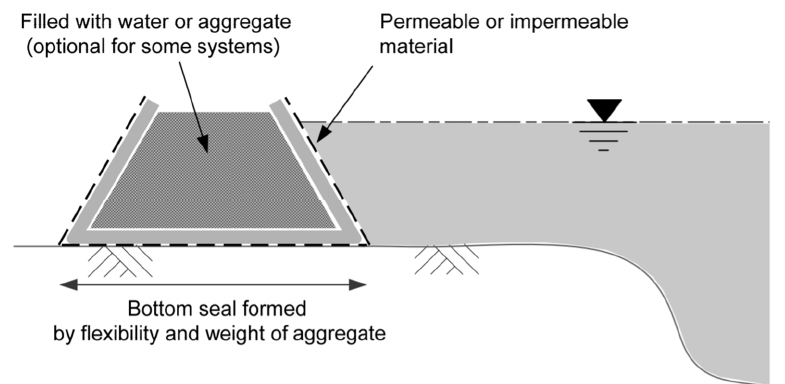
Figure 2. Permeable and impermeable bulk bag structures, derived from Ogunyoye et al.